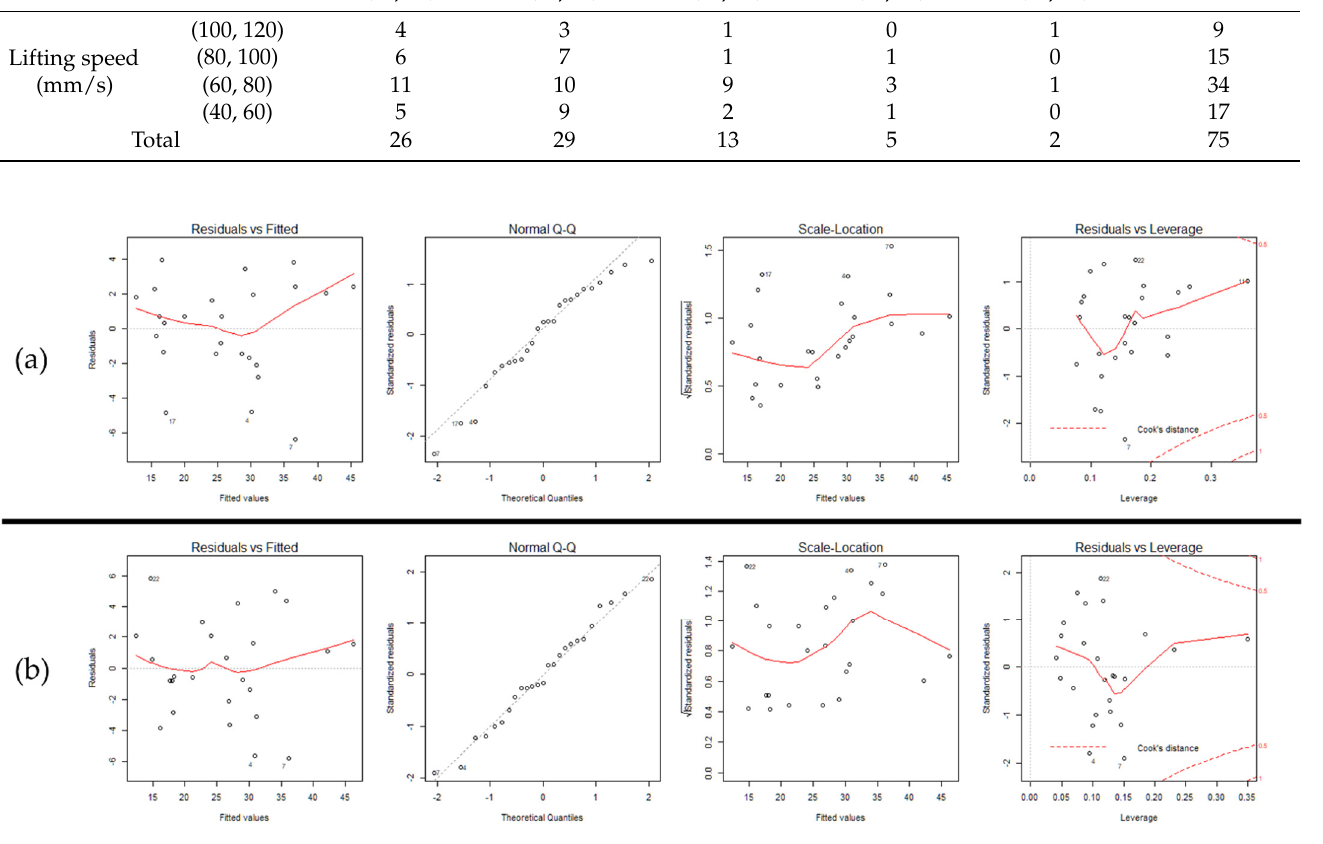
Figure 4. Goodness-of-fit of the two 1RM equations’ load weight 𝑊 and lifting speed 𝑣 : ( a ) 1RM =